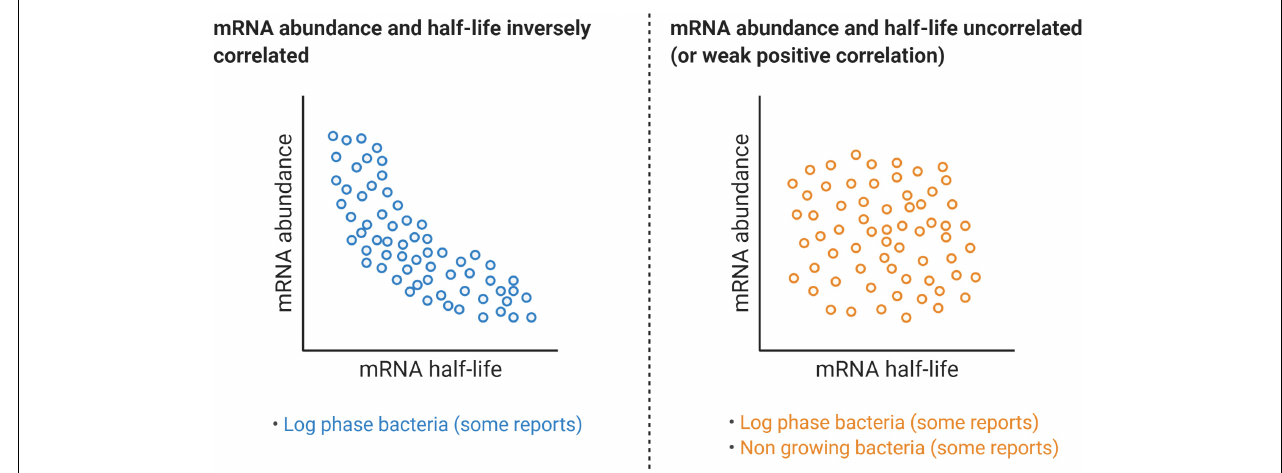
FIGURE 7 | Relationships between mRNA abundance and mRNA decay rates. While some reports have shown a clear negative correlation between a transcript half-life and its abundance, a similar number of reports have found no correlation at all or a modest positive correlation, even for the same organism. Table 1 compiles transcriptome-wide analyses of mRNA decay in different organisms, techniques used, and information on the reported relationships between mRNA abundance and mRNA half-life.